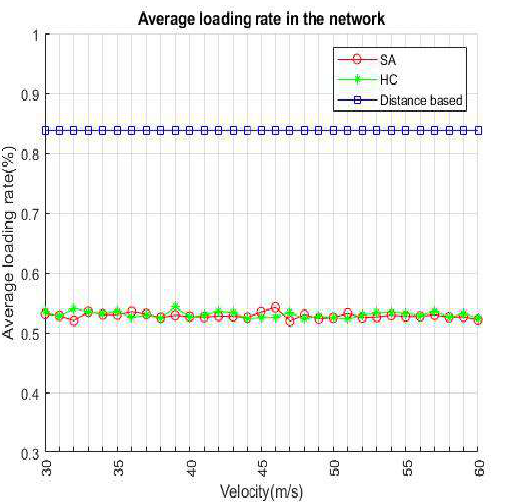
Figure 11. Average loading per